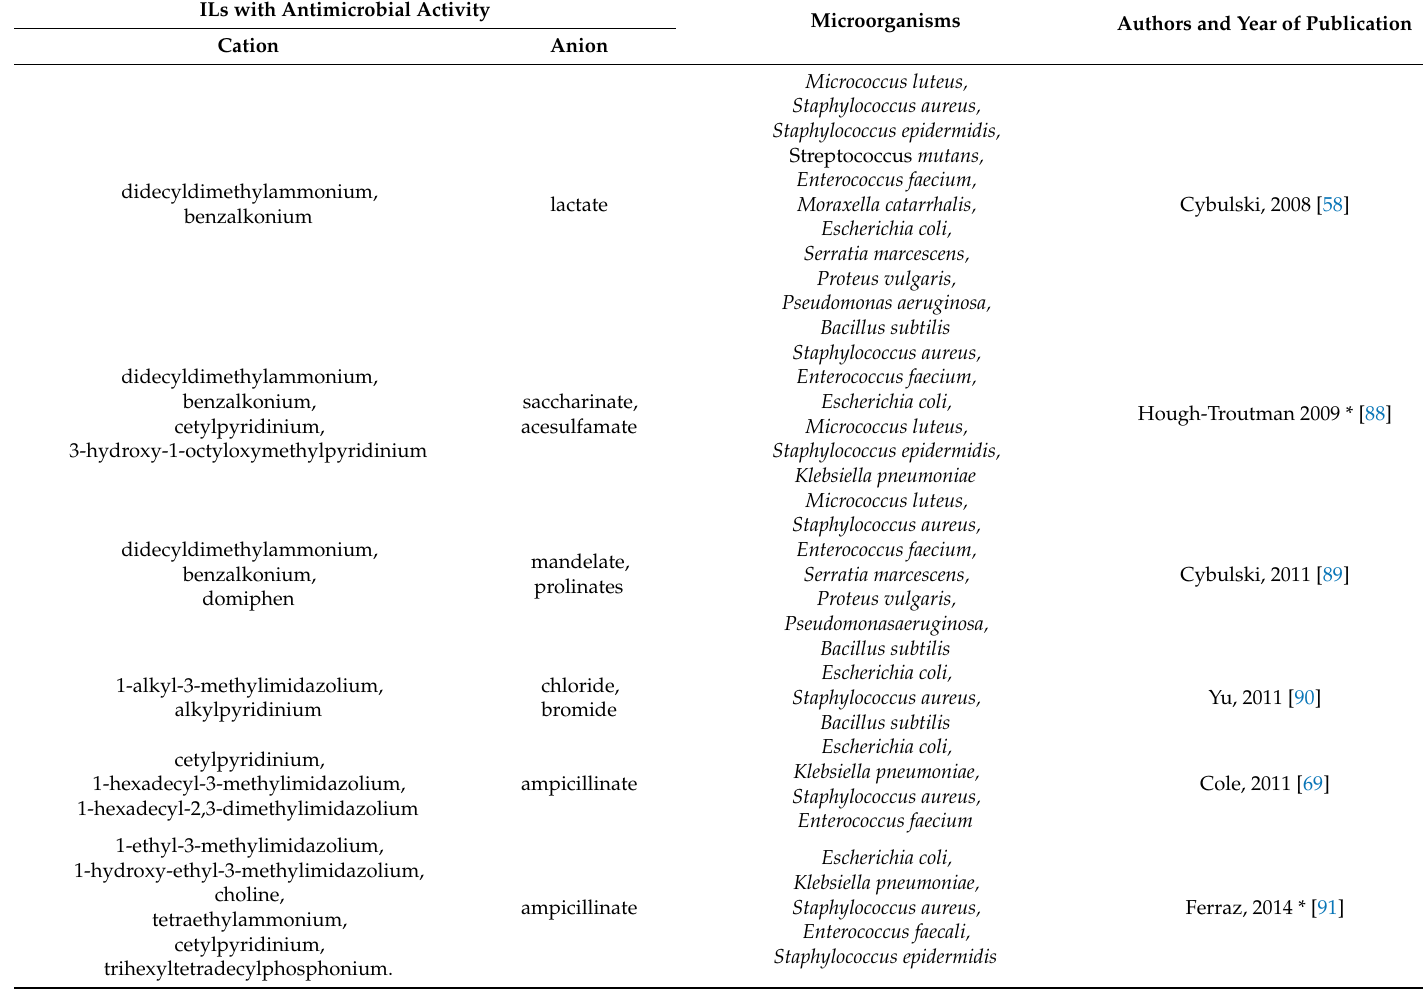
Table 1. Brief summary of ILs with antimicrobial